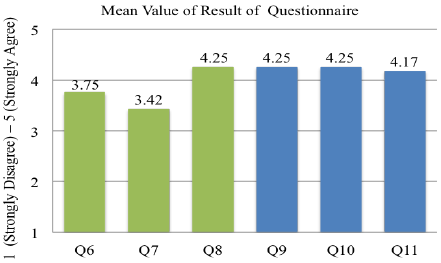
Figure 12. The usability and users’ satisfaction of questionnaire results of the